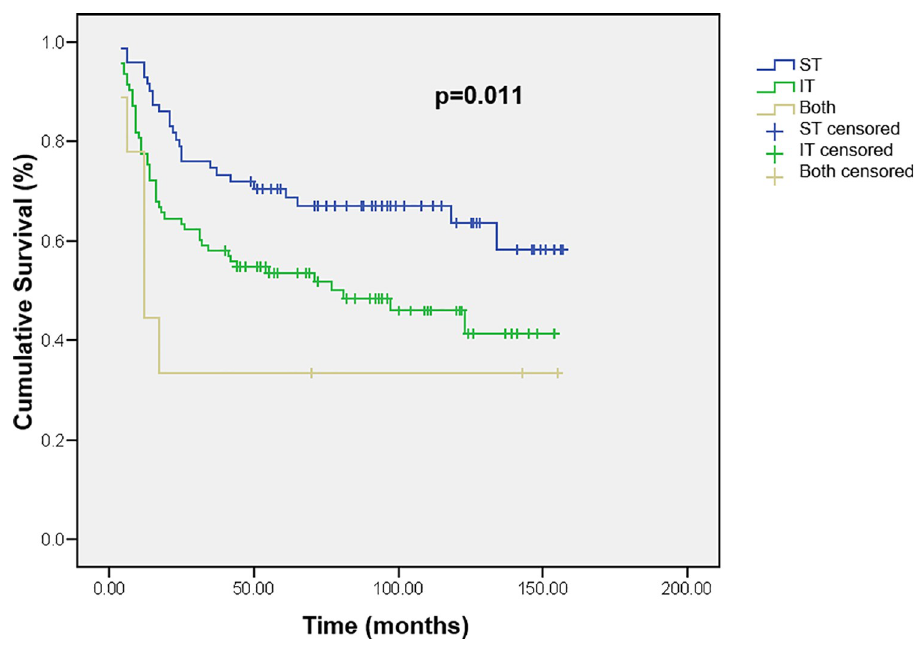
Fig 3. Cumulative survival of children with brain tumors according to tumor location. ST—supratentorial tumors, IT—infratentorial tumors, Both—tumors with both (supratentorial and infratentorial) locations involvement.